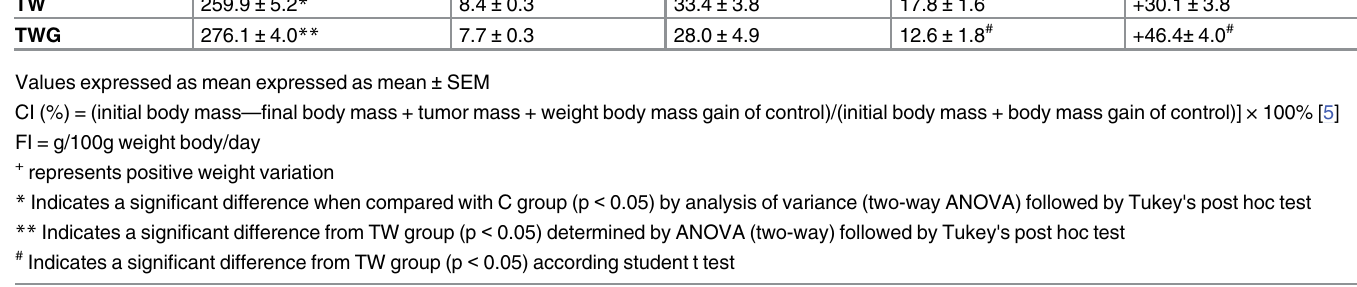
Table 3. Physiological parameters assessed in experimental groups. Final weight body (FW), food intake (FI), tumor mass (TM), weight variation (WV). Experimental groups: control (C), control supplemented with L-glutamine (CG), Walker 256 tumor (TW) and Walker 256 tumor supplemented with L-gluta- mine (TWG). n = 8 rats per group.